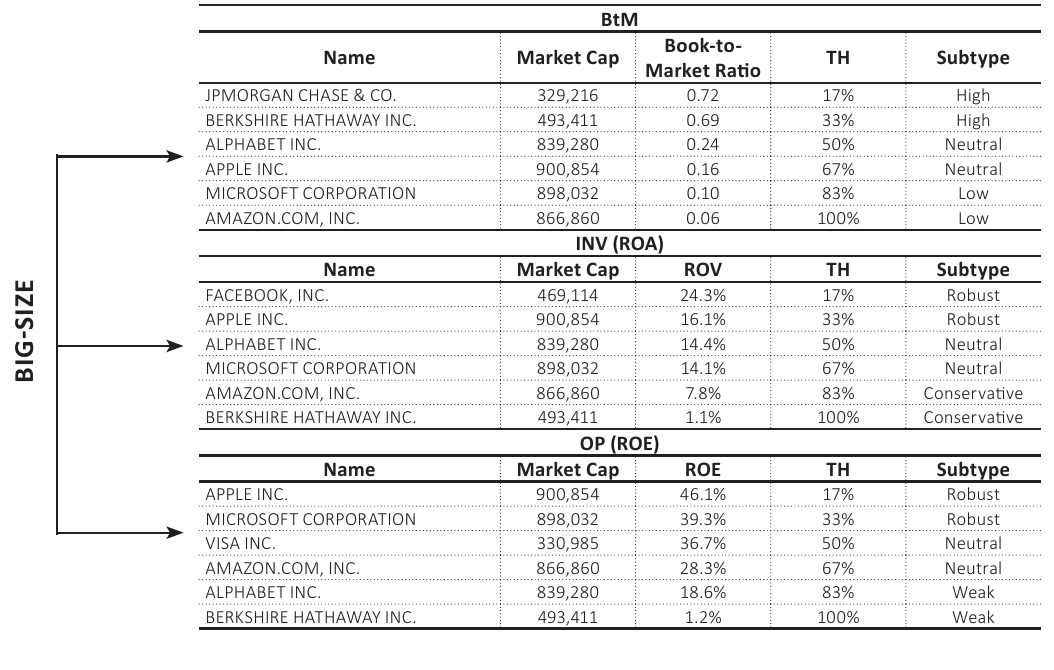
Figure 1. Share allocation across big-size portfolios